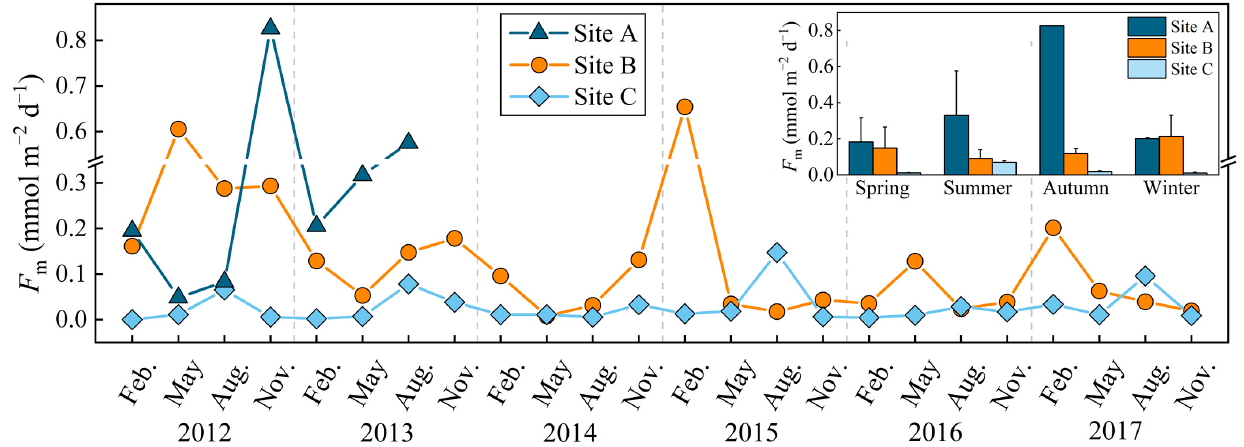
Figure 5. Temporal variation in diffusive CH 4 emission flux ( F m ) at the three sampling sites of Lake Taihu based on long-term (2012–2017) field measurement. The insert graph represents the seasonal mean CH 4 flux.